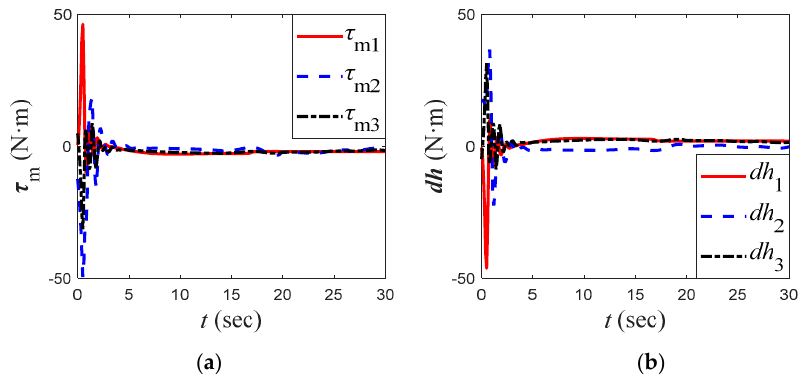
Figure 13. ( a ) Control torque of the manipulator; ( b ) The derivative of angular momentums of the CMGs.